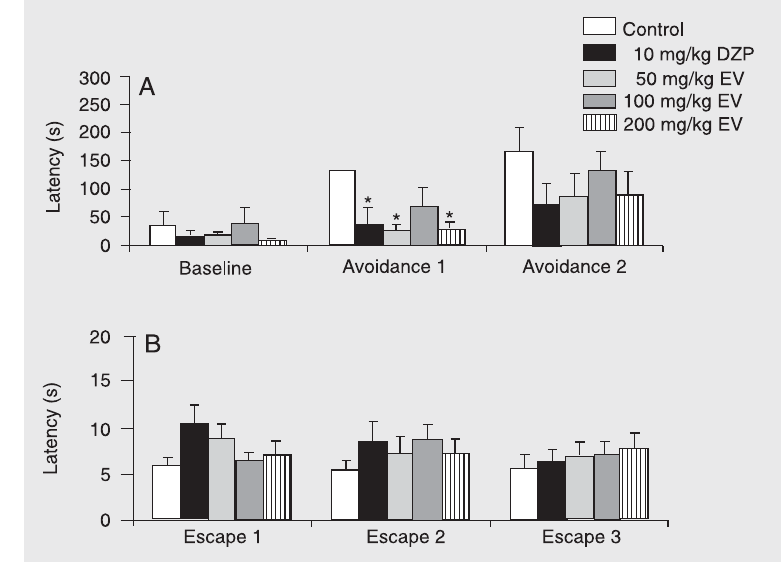
Figure 2. Effect of chronic oral administration of a water-alcohol extract of Erythrina velutina (EV) and of diazepam (DZP) on the behavior of rats submitted to the avoidance (panel A) and escape (panel B) tasks of the elevated T-maze. Data are reported as means ± SEM. N = 12 for control, DZP, and 50 and 100 mg/kg EV and N = 11 for 200 mg/kg EV. *P < 0.05 compared to control (Duncan